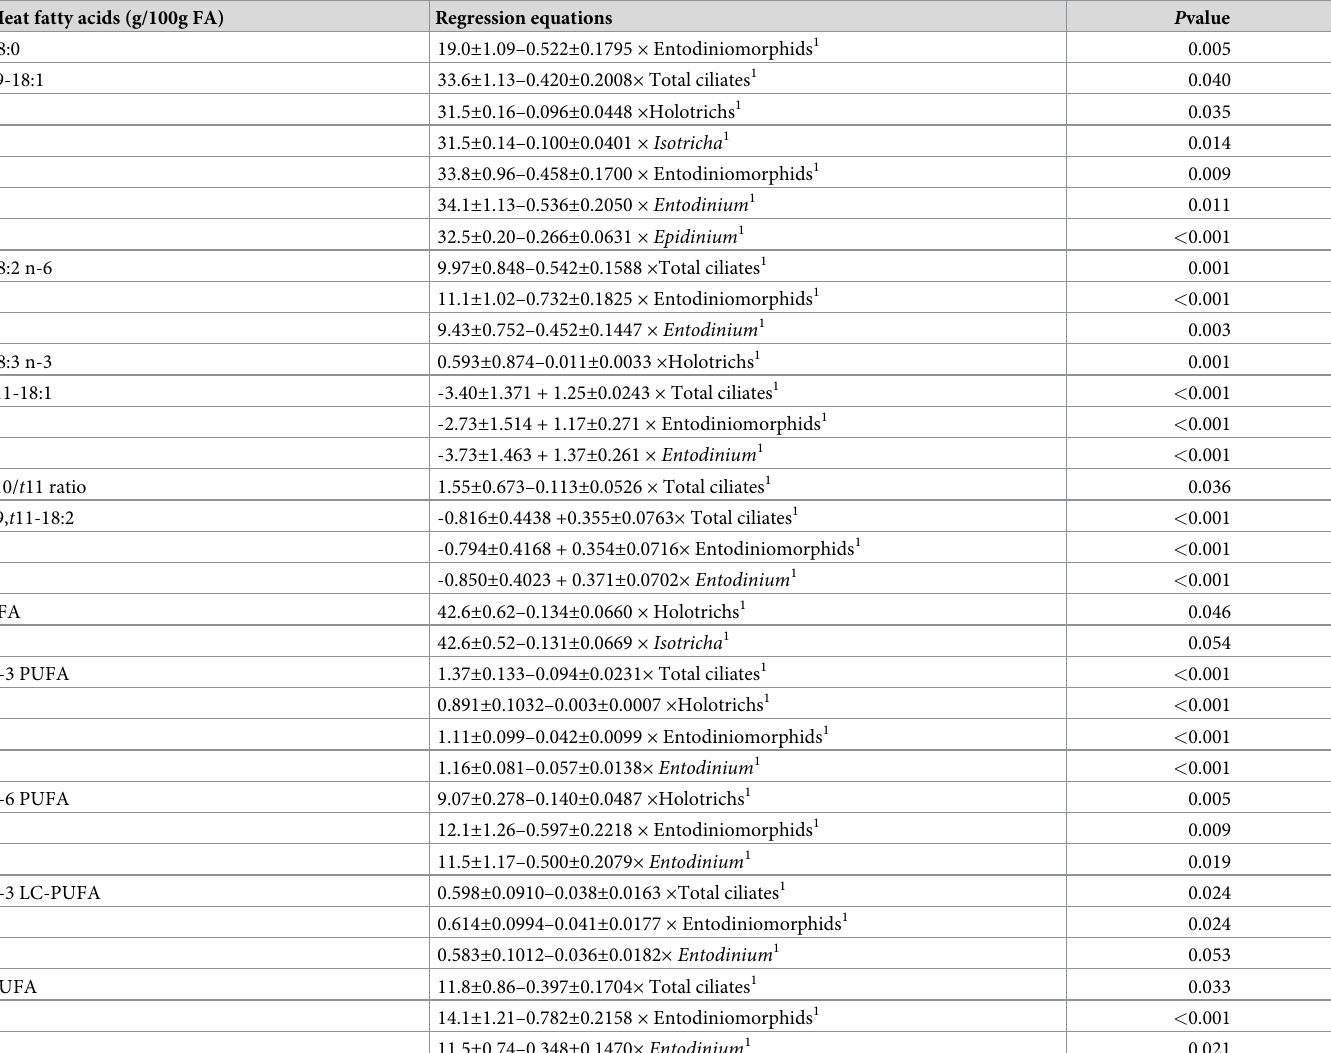
Table 6. Significant linear regression equations between rumen ciliates (log 10 cells/ml) and meat FA. Meat fatty acids (g/100g